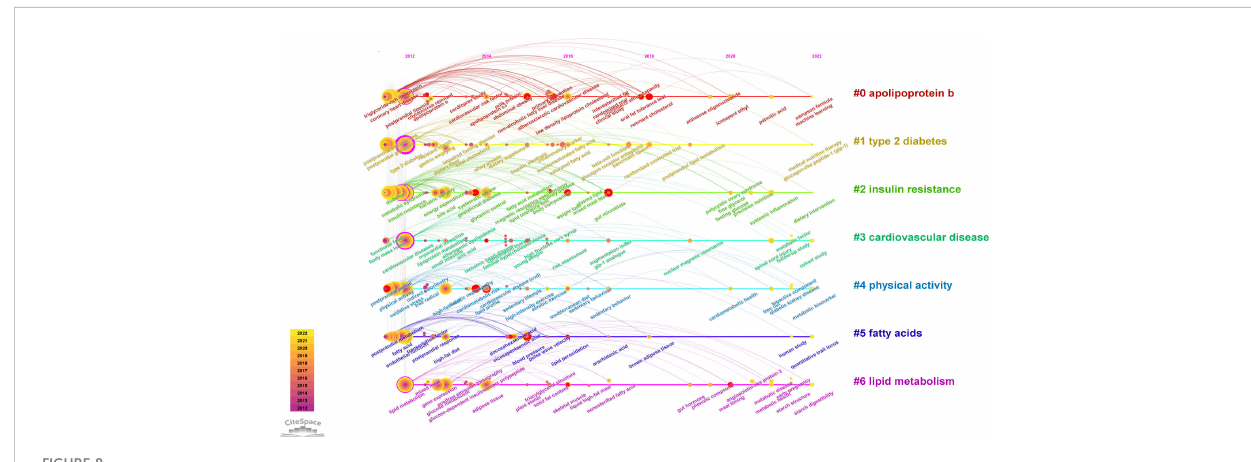
FIGURE 8 Timeline view of co-citation